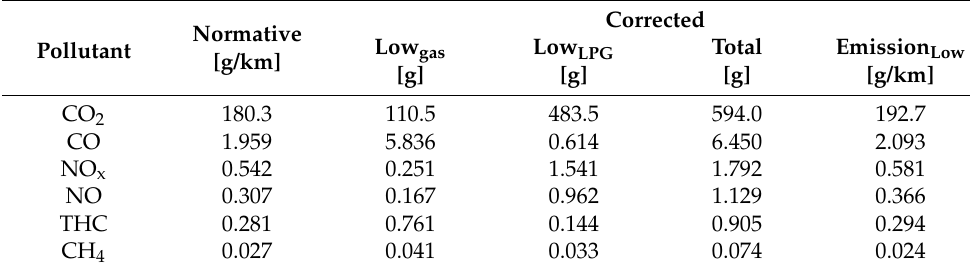
Table A5. Comparison of exhaust emissions calculated by the normative and corrected method for the Low phase of the WLTC cycle—measurement No.